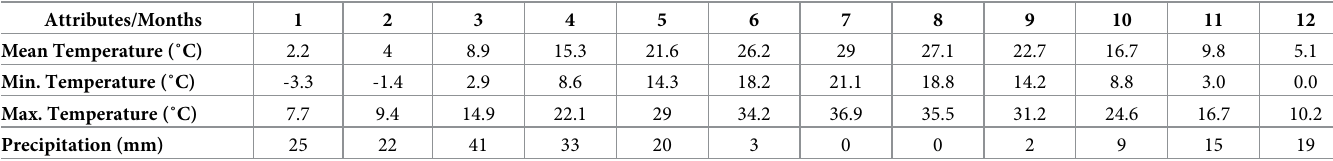
Table 1. Averages of long-term climate data of the Dushak city, Turkmenistan